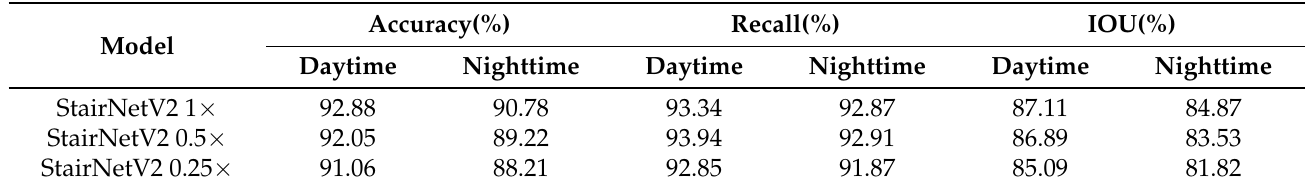
Table 5. Accuracy, recall, and IOU of the models on the daytime and nighttime